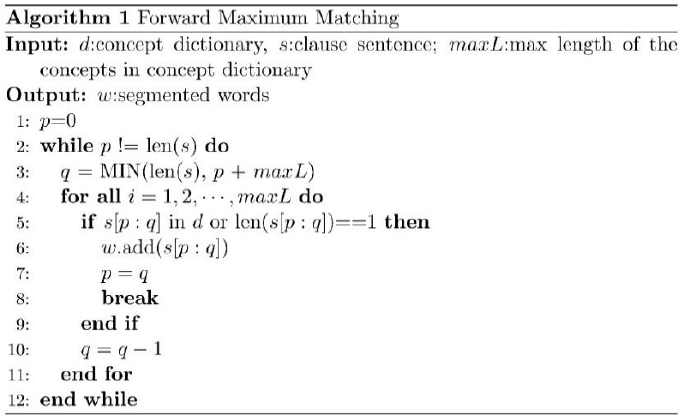
Figure 5. Algorithm of forward maximum matching for the Chinese segmentation task.